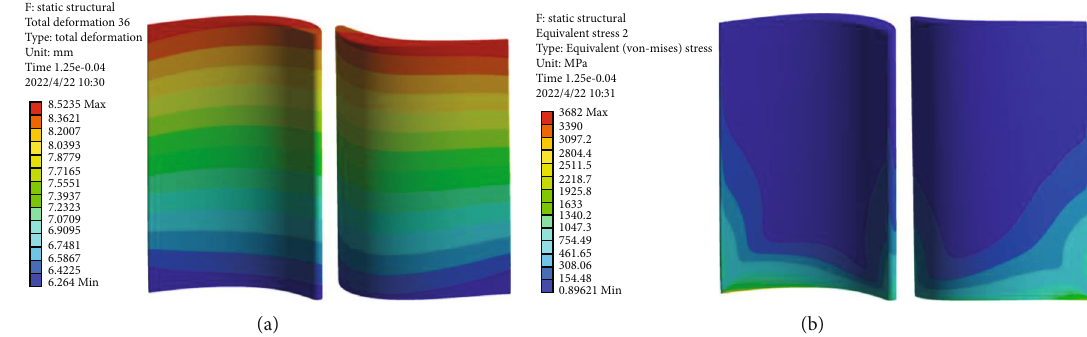
Figure 10: The contours of normal blades. (a) Deformation. (b)